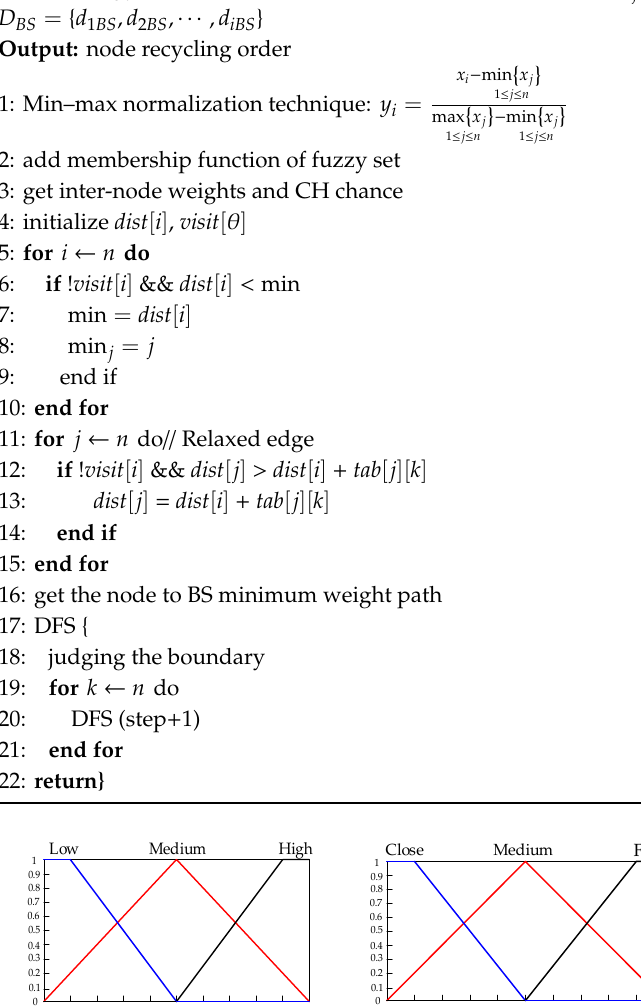
Algorithm 2 Compute node recovery order